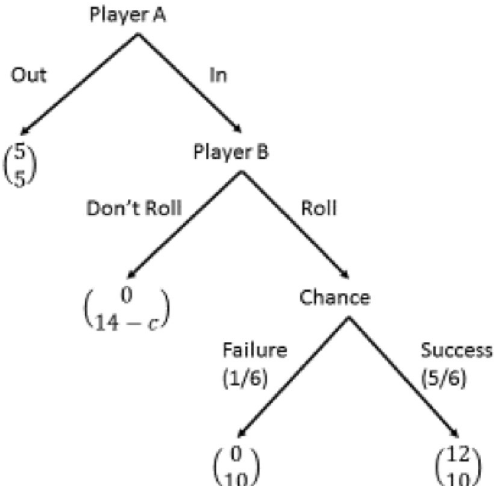
Figure 6. The trust game in the ‘promise’ conditions with lying